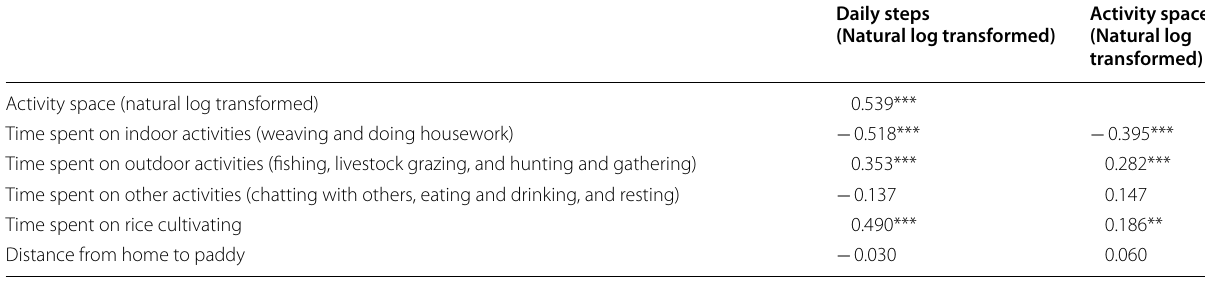
Table 5 Pearson correlation